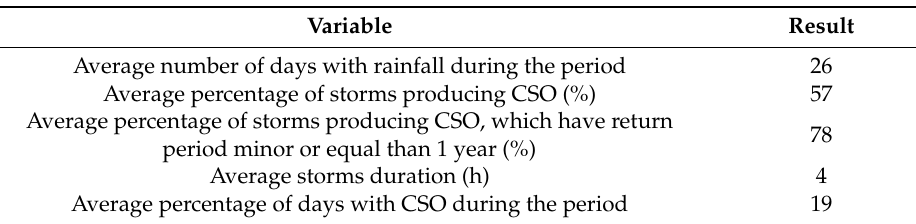
Table 1. Summary of results from continuous simulation.